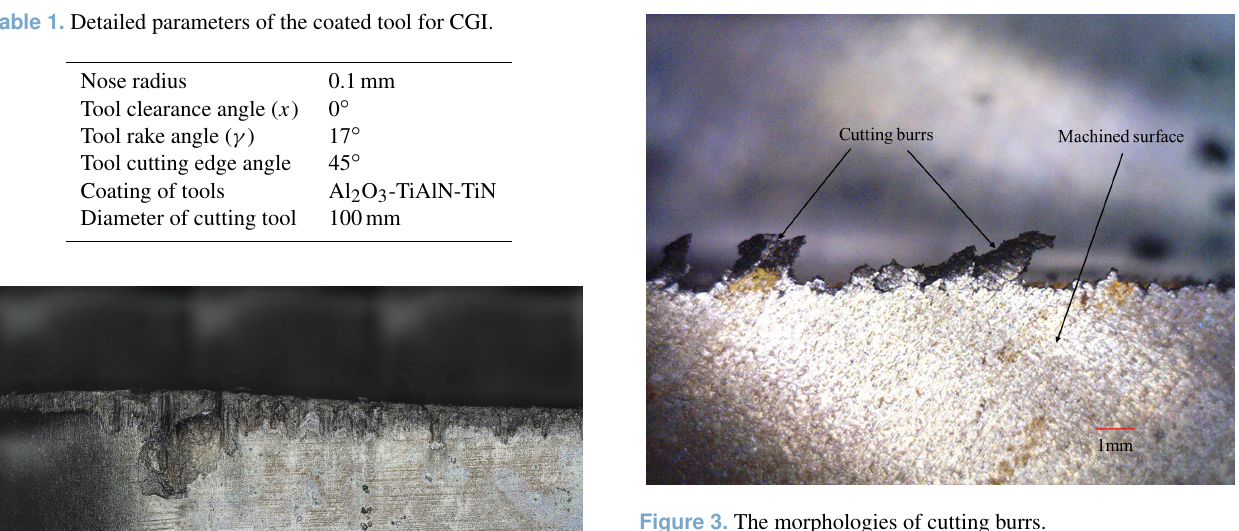
Figure 3. The morphologies of cutting